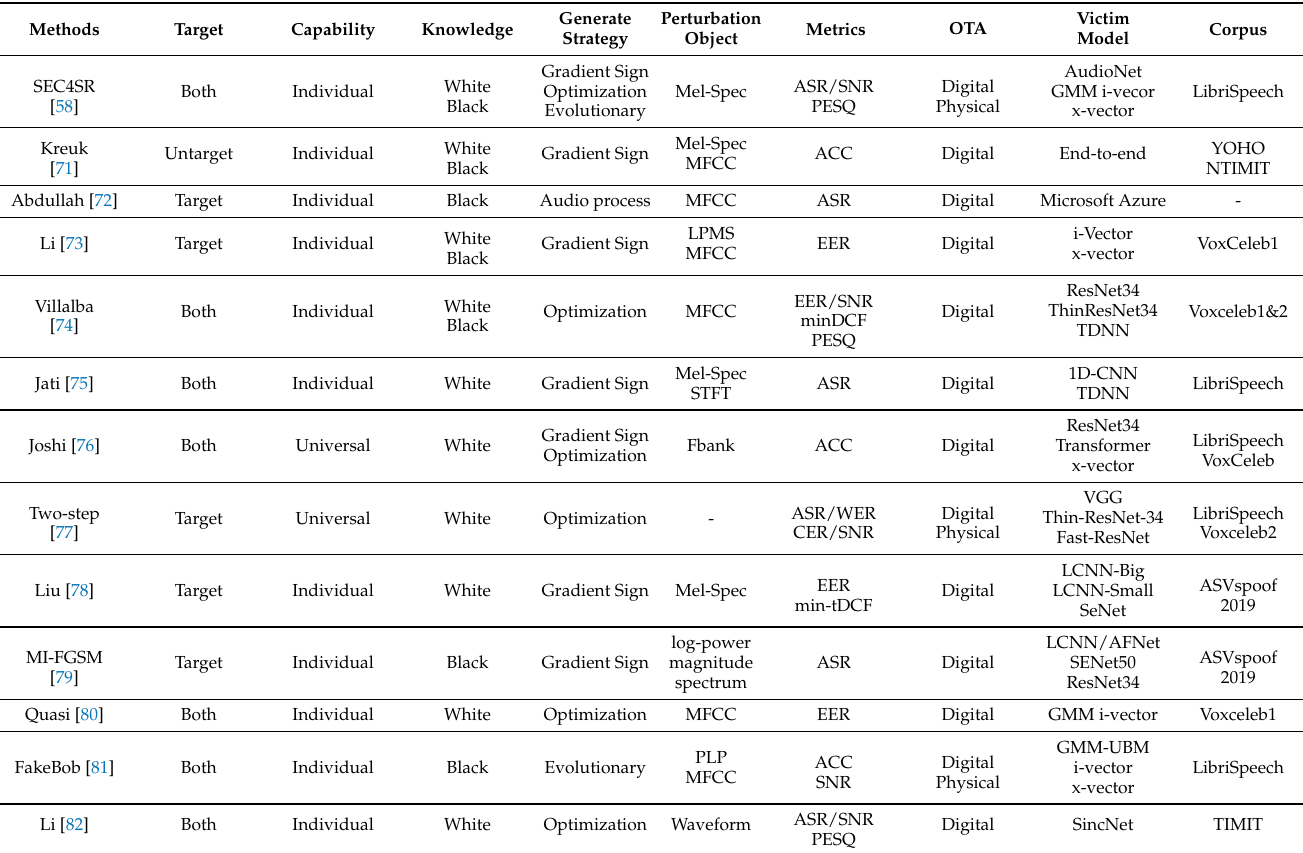
Table 3. Related works on adversarial attacks against existing